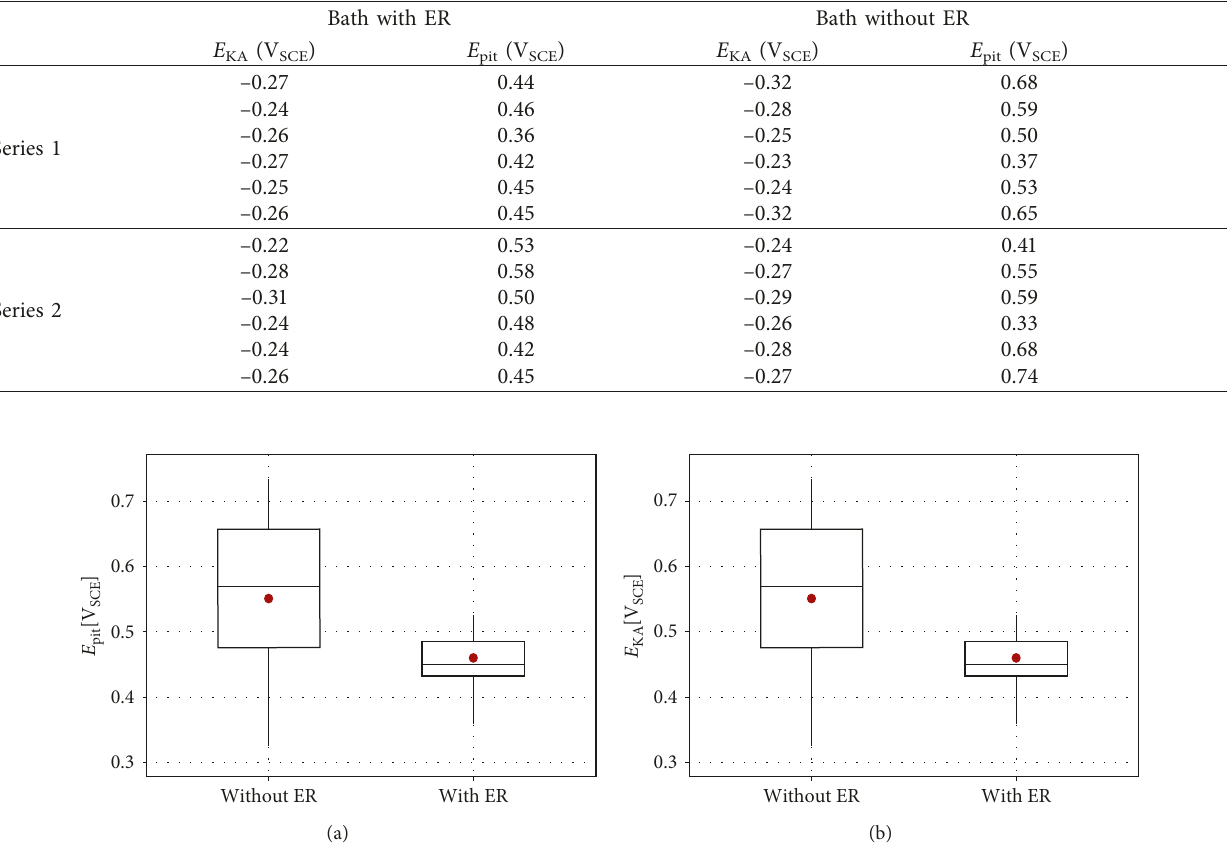
Figure 9: Comparison of E pit and E KA between groups with and without electrochemical reduction (dot-mean;